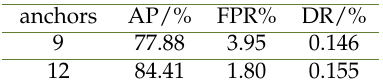
Table 3. Experimental results of different anchors.